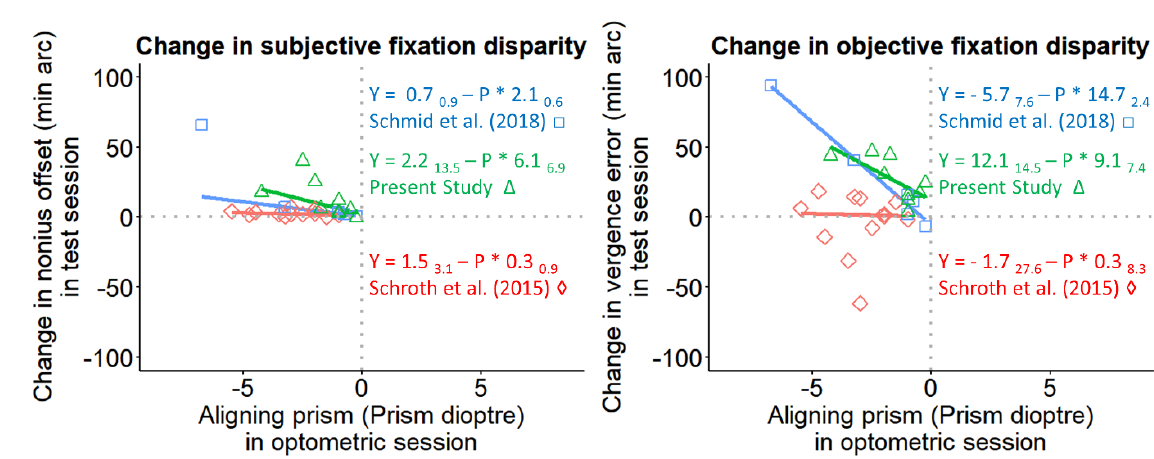
Figure 5 Comparison between the three relevant studies with respect to the prism-effect versus the amount of the aligning prism in base-in cases. Data points, shown as green triangles, represent the present study of one minute prism wearing, blue squares represent Schmid et al. (2018) of a few seconds prism wearing and red diamonds refers to Schroth et al. (2015) with five weeks prism